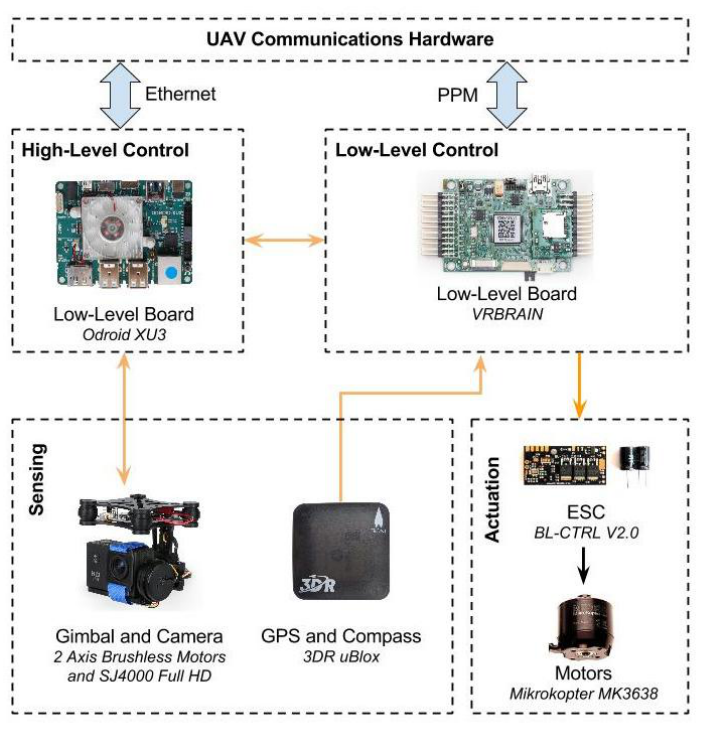
Figure 8. The UAV’s hardware architecture. Orange arrows represent serial connections between low-level and high-level control boards, sensors and actuators. The UAV communications hardware block abstracts the components for wireless communications, whose details are discussed in Section 5.2. This block communicates with both high-level and low-level boards through Ethernet and PPMconnections, respectively, represented with blue arrows.